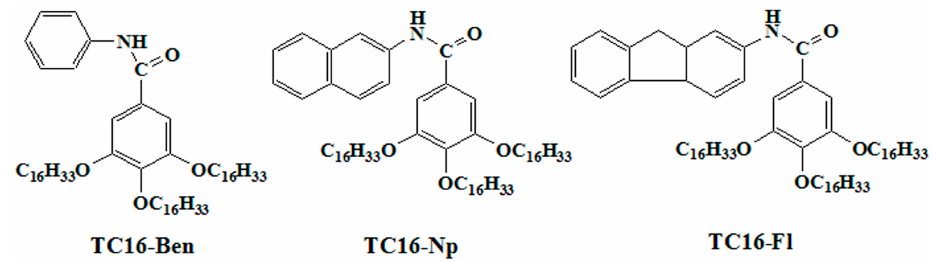
Figure 1. Molecular structures and abbreviations of three obtained amide derivatives.